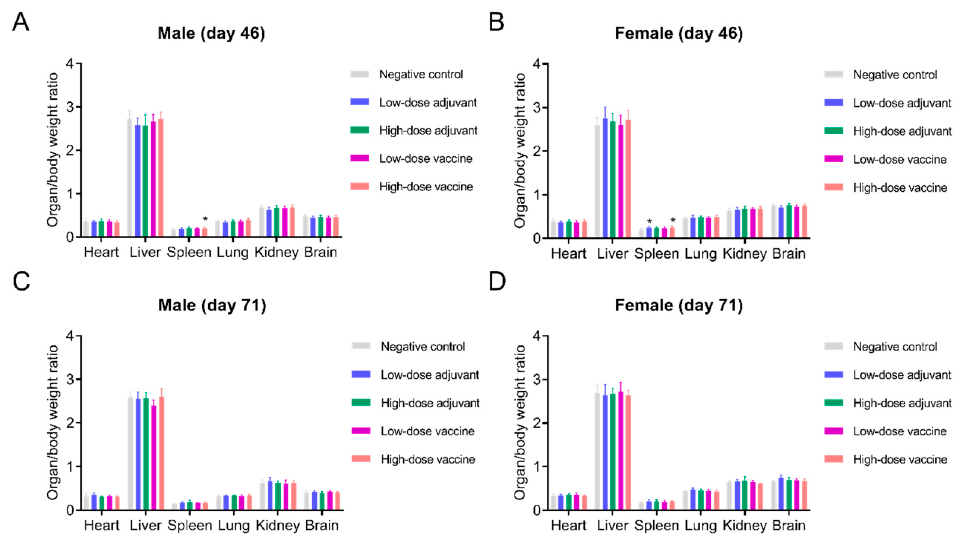
Figure 5. Clinical evaluation of rats in different groups. ( A , B ) Organ/body weight ratios at day 46 ( n = 10). ( C , D ) Organ/body weight ratios at day 71 ( n = 5), * p < 0.05.